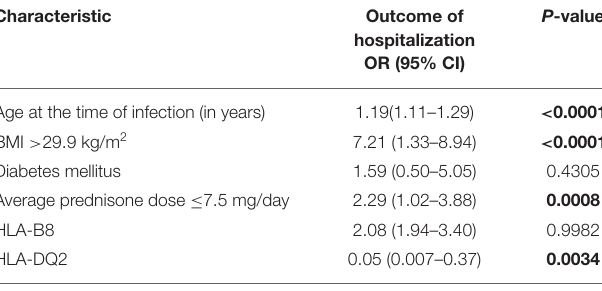
TABLE 4 | Multivariable analysis (log regression), outcome of hospitalization (adjusted for time after KT, sex, tacrolimus level, and MMF).